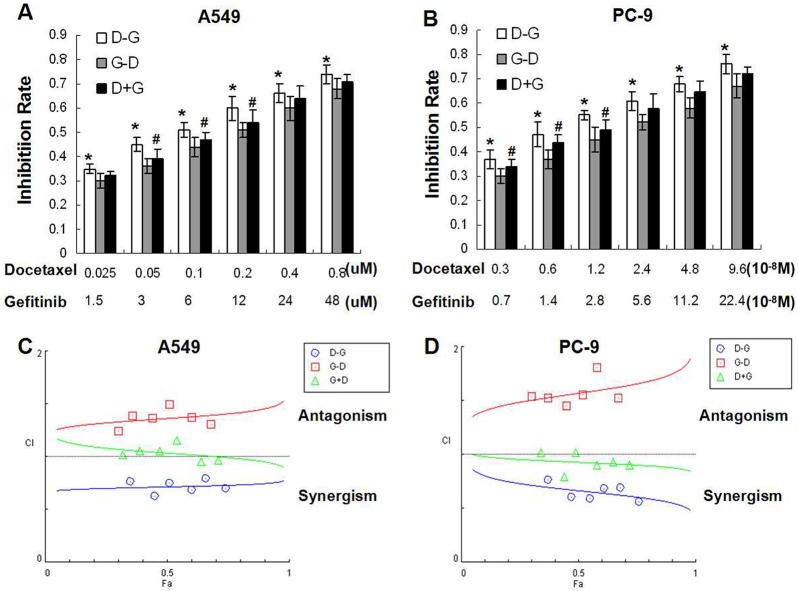
Effects of different exposure schedules of gefitinib and docetaxel on cell proliferation.Cells were treated with three different sequences of gefitinib and docetaxel (D→G; G→D; D+G). The drug doses were combined using constant ratios of IC50 values (0.125, 0.25, 0.5, 1, 2 and 4 times of IC50). (A, B) The inhibition rate was determined by MTT assay. *P<0.05, D→G versus G→D; #P<0.05 D→G versus D+G. The D→G sequence produced the most potent inhibitory effect. (C, D) The combination index (CI) was calculated using CompuSyn software. Only the D→G sequence showed synergistic effect. (D–G) docetaxel followed by gefitinib; (G–D) gefitinib followed by docetaxel; (D+G) docetaxel and gefitinib administered concurrently. Bars: ± SD, n = 3.